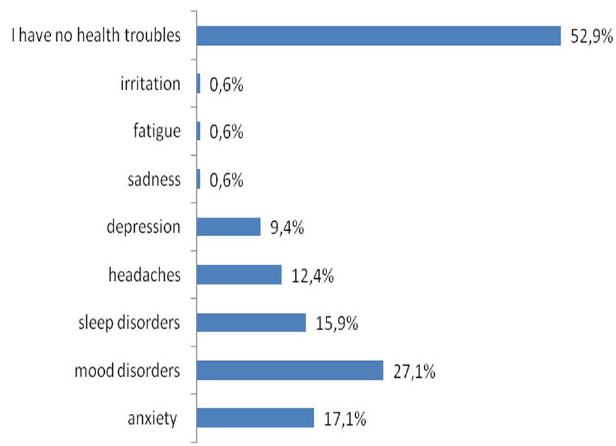
Figure 5. The impact of the Covid-19 pandemic on employ- ees’ health condition*. * Respondents could select more than one answer.